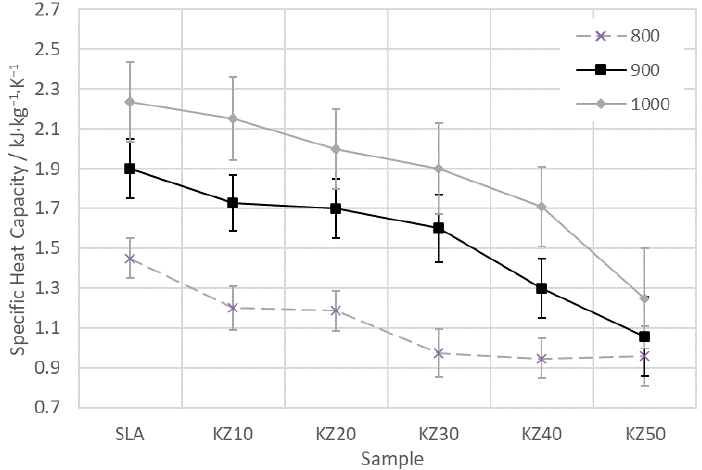
Figure 13. Specific heat capacity of the studied samples at 800, 900, and 1000 °C.